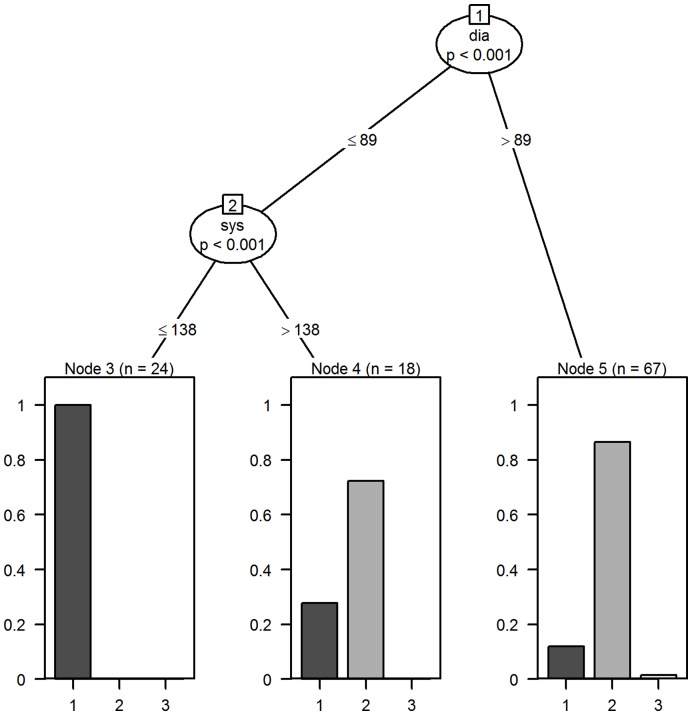
Tree model for decisions made at the first visit for all vignettes.Terminal nodes have proportion on the y-axis and decision code (1 to 3) on the x-axis. Sys is systolic BP and dia is diastolic BP.